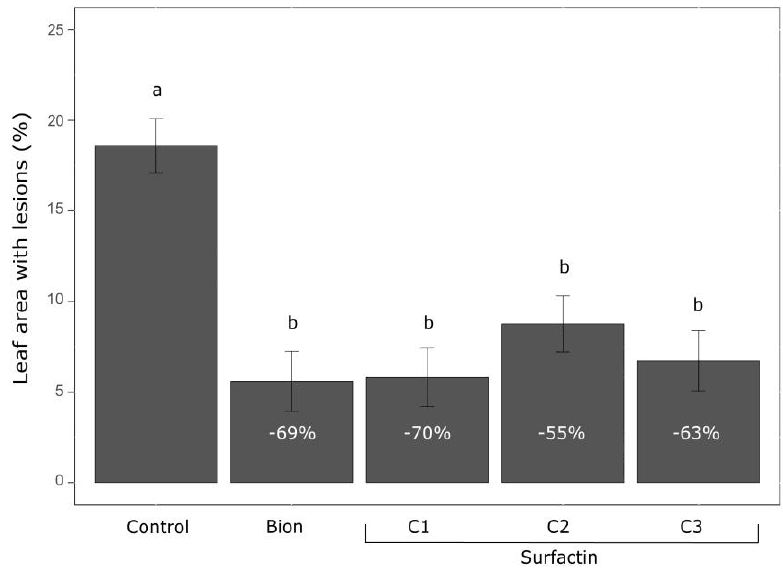
Figure 1. Mean disease severity of Zymoseptoria tritici on treated wheat plants. Data corresponds to the average percentage of the third leaf surface of wheat plants exhibiting symptomatic lesions (necrosis and/or chlorosis) bearing pycnidia. Plants were treated at the 3–4 leaf stage and five days before inoculation with water (Control), surfactin (Surfactin), or Bion ® 50WG (Bion, Syngenta Europe). Surfactin was applied at three different concentrations: 0.001 mg mL − 1 (C1), 0.01 mg mL − 1 (C2) and 0.1 mg mL − 1 (C3). Bion was used as an elicitor reference and applied at 0.6 mg mL − 1 . The protection efficacy of each treatment compared to water treated plants is represented in white inside the bars and corresponds to the percentage of reduction of disease severity. Bars tagged with the same letters correspond to means that are not significantly different using the Tukey test at p = 0.05 ( n ≥ 40, e.g., 5 pots of 8 plants per treatment × 2 independent experiments).